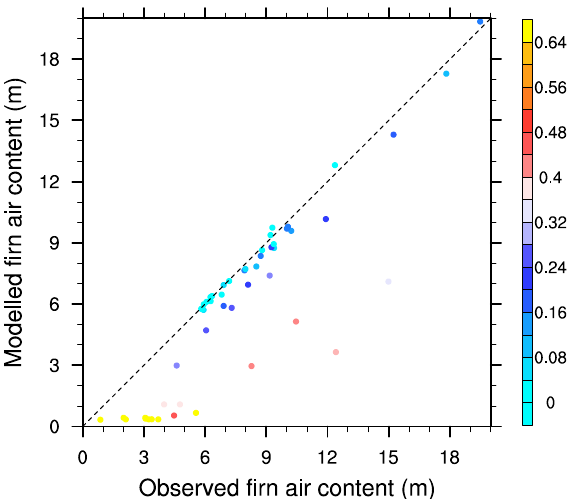
Figure 4. Modelled vs. observed firn air content F (in m) for 59 of the 62 firn cores (cores H2-1, H3-1, and H4-1 are not shown). The colour scale to the right indicates the ratio of modelled mean melt and accumulation fluxes R ma , and the colour of each dot in the scatter plot corresponds to the value of R ma for that firn core